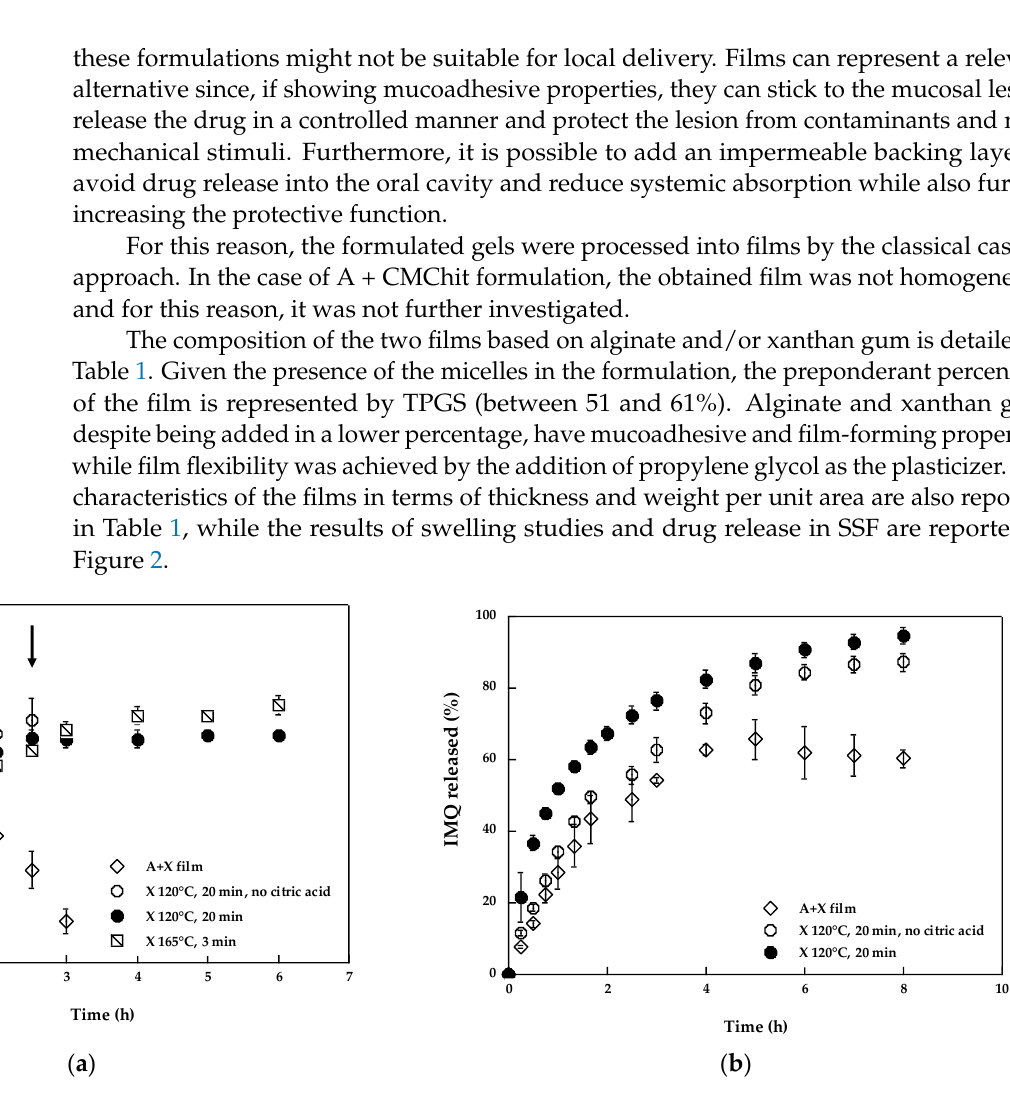
Figure 2. ( a ) Swelling profile of films in SSF (mean ± sd). The arrow indicates the loss of cohesion of the hydrogel; ( b ) IMQ release from films (mean ± sd).